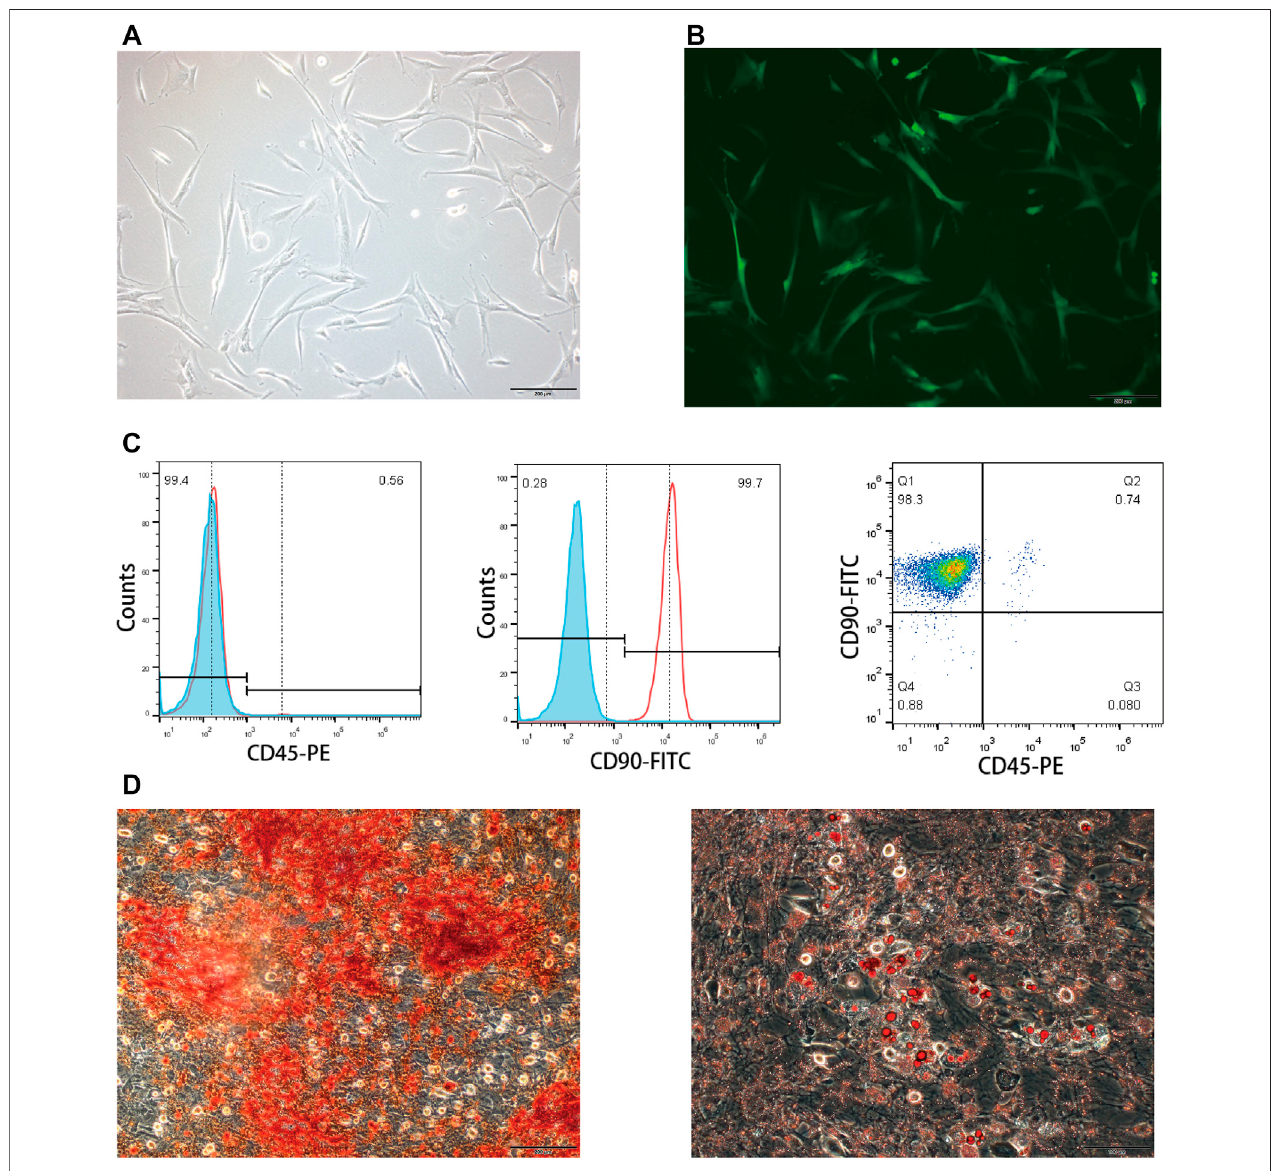
FIGURE2| Characterization ofratBMSCs. (A) Bright fi eldimageshowedthetypical fi broblastmorphologyofpuri fi edBMSCs. (B) EGFPexpressionoftransfected BMSCsmeasuredbya fl uorescencemicroscope. (C) ImmunophenotypeofBMSCswasexaminedby fl owcytometry;CD90wasthepositivemarkerandCD45wasthe negative marker. (D) Oil Red O and Alizarin Red S staining were carried out to determine the differentiating abilities of BMSCs.